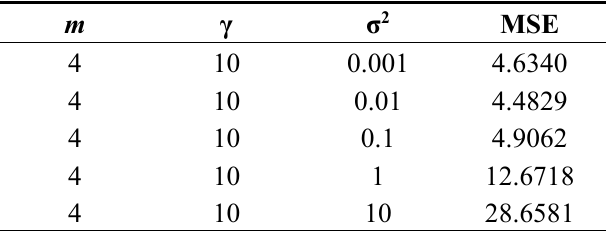
Table 3. The influence of σ 2 on prediction precision.